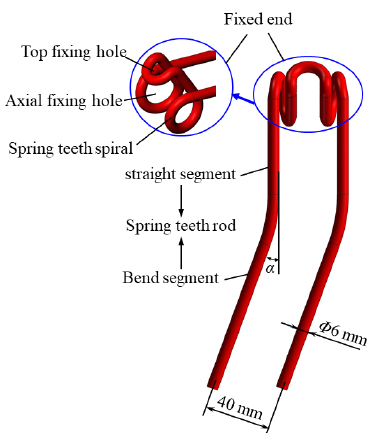
Figure 8. Structure diagram of spring teeth.